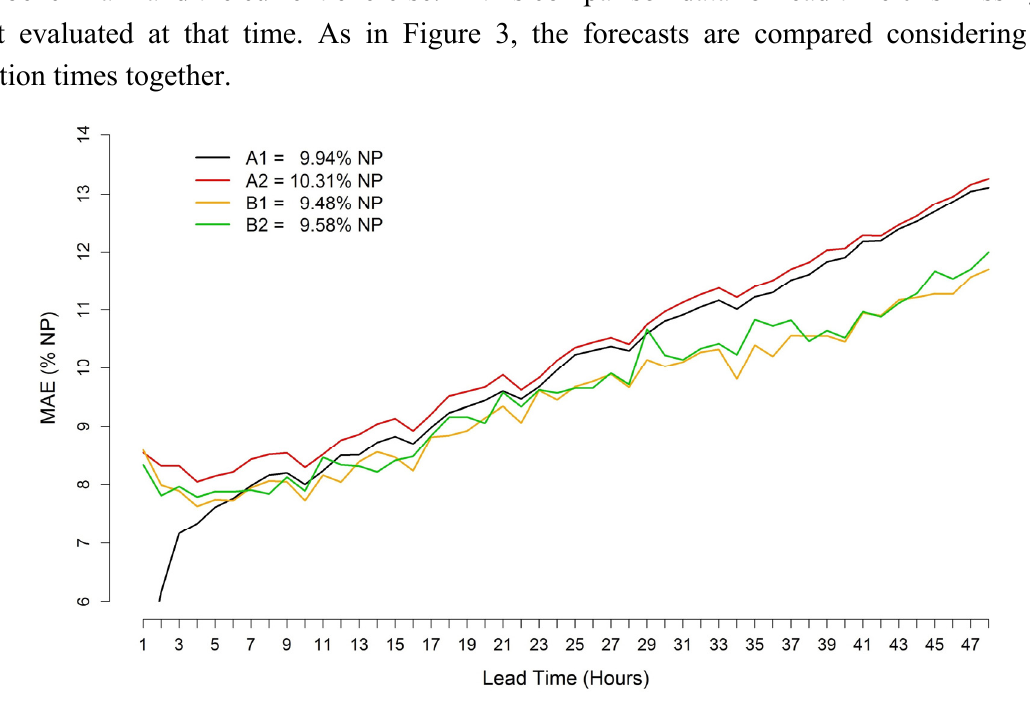
Figure 5. Comparison between new and old results in term of MAE / NP as a function of forecast lead time (1–48 h ahead) for the wind power forecasts issued at 0, 6, 12 and 18 UTC for the Klim test case. A1, A2 and B1, B2 are the best 2 forecasts of the previous benchmark and the current work